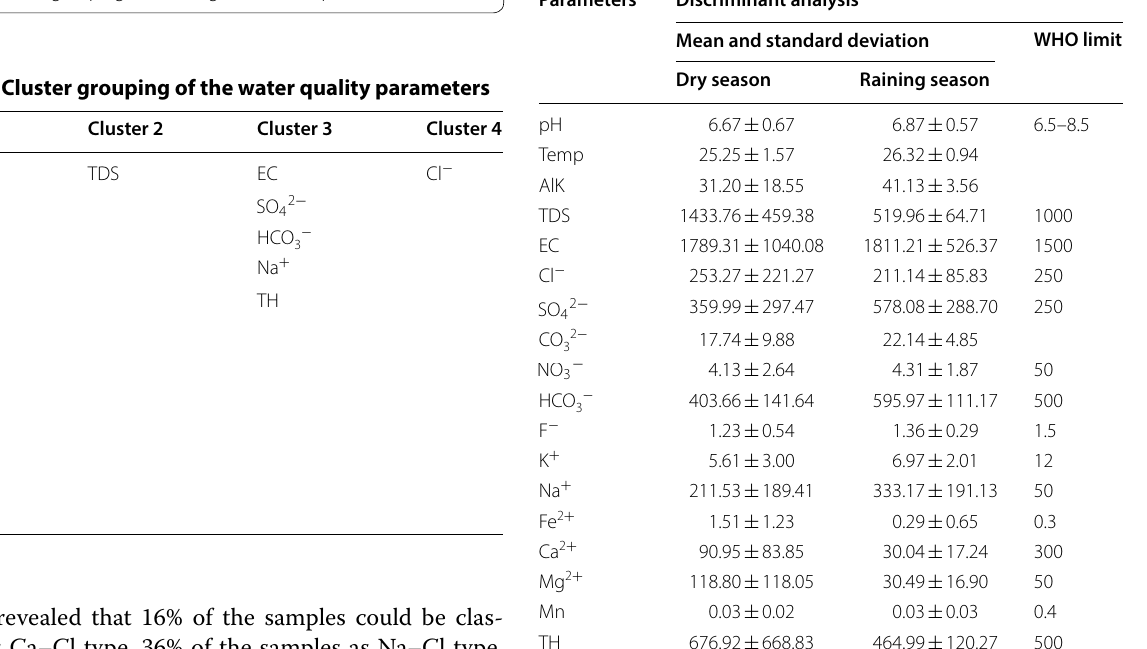
Fig. 2 Cluster grouping based on ground water parameters